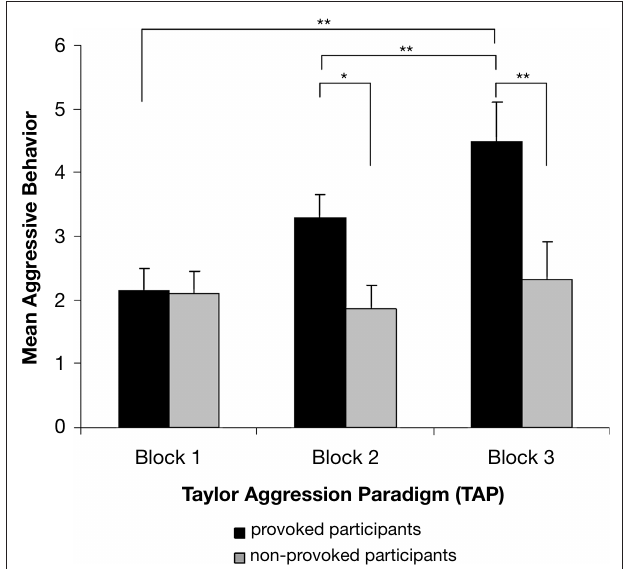
FIGURE 2 | Mean aggressive behavior of the provoked and the non- provoked group in the three blocks of the Taylor aggression paradigm. Note: mean aggressive behavior represents the average of the loudness and duration setting. Each block consists of 10 trials (block 1: trial 1 to 10, block 2: trial 11 to 20, block 3: trial 21 to 30). The error bars represent ± 1 standard